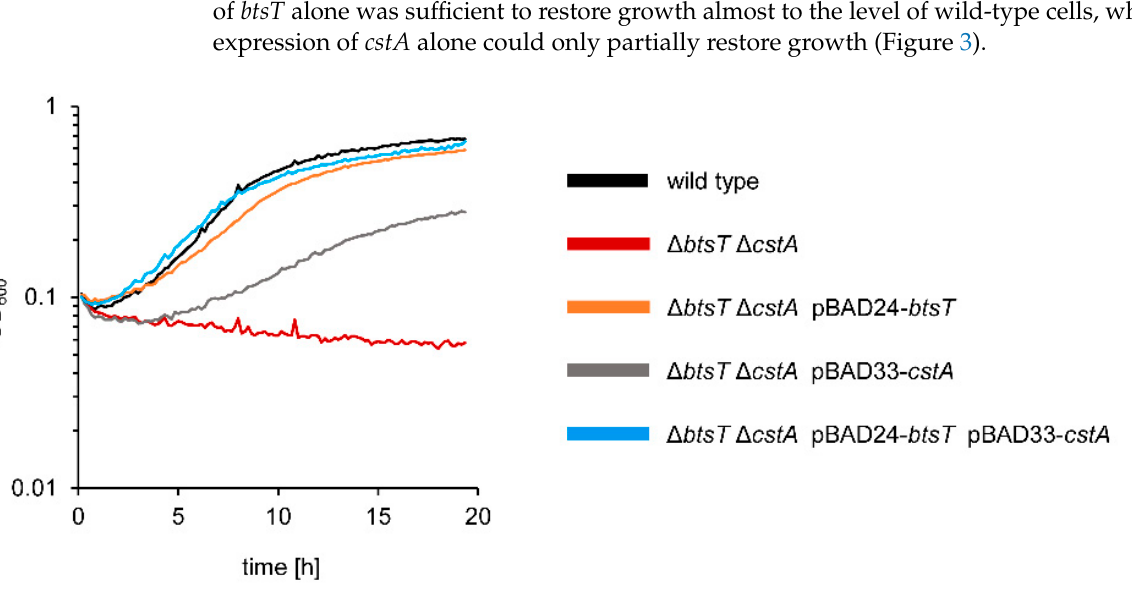
Figure 3. S . Typhimurium mutant Δ btsT Δ cstA is unable to grow on pyruvate. SL1344 wild-type cells and Δ btsT Δ cstA mutant harboring the indicated plasmid(s) were grown in M9 minimal medium with 60 mM pyruvate in a plate reader at 37 °C.